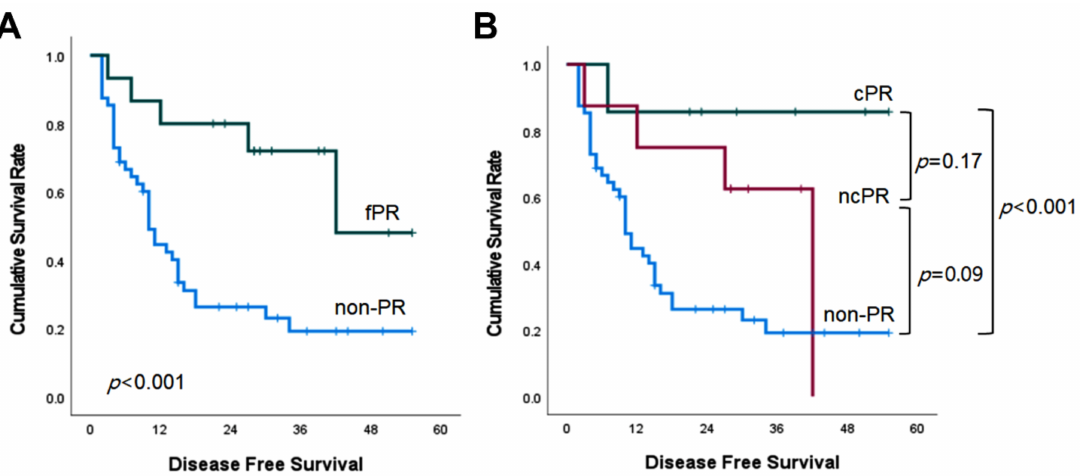
Figure 2. Kaplan–Meier survival curves of disease-free survival according to pathologic response.